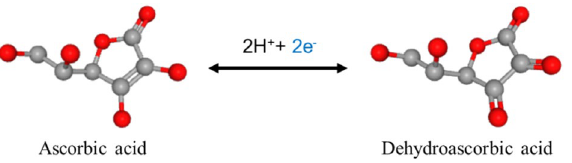
Figure 1. The oxidation of ascorbic acid to dehydroascorbic acid (adapted with modifications from PubChem database 22